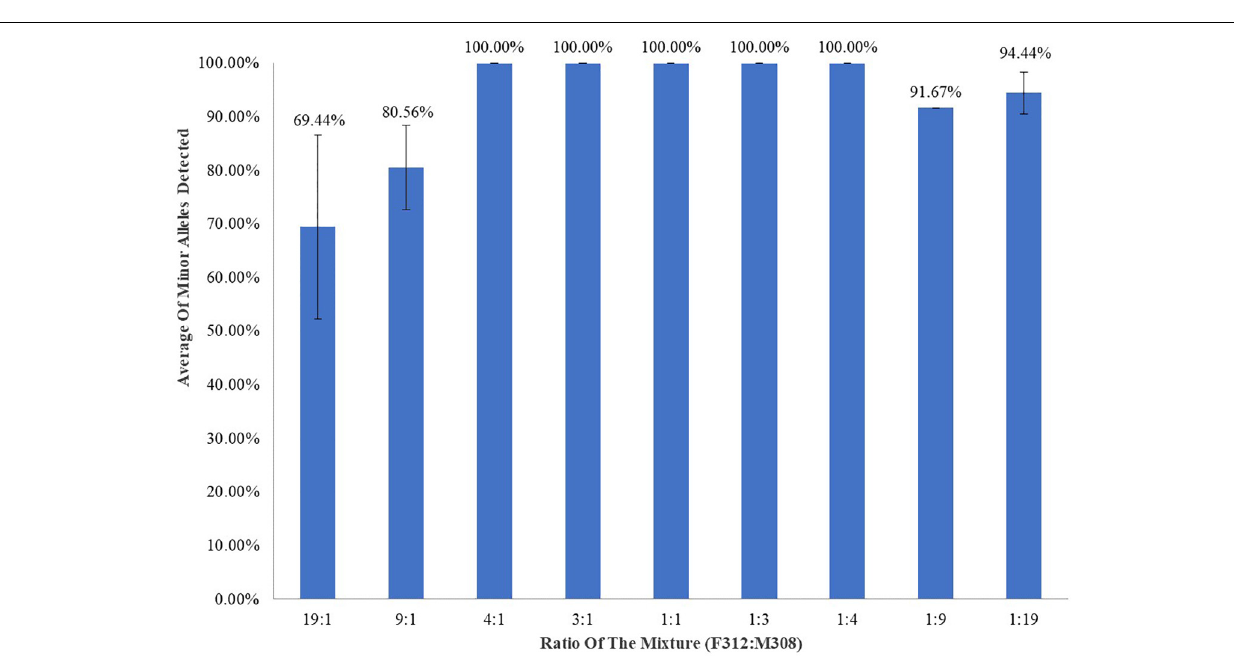
FIGURE 3 | F312/M308 DNA amplification using 1 ng of total DNA and assessed in